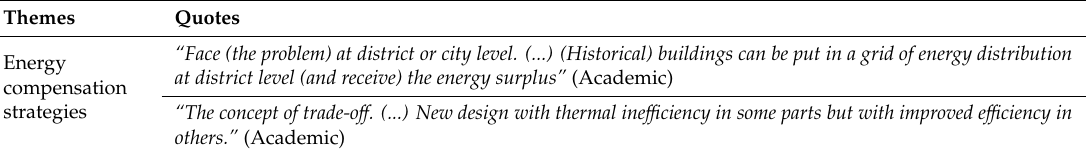
Table 3. Barriers in mitigating climate change in the cultural built heritage